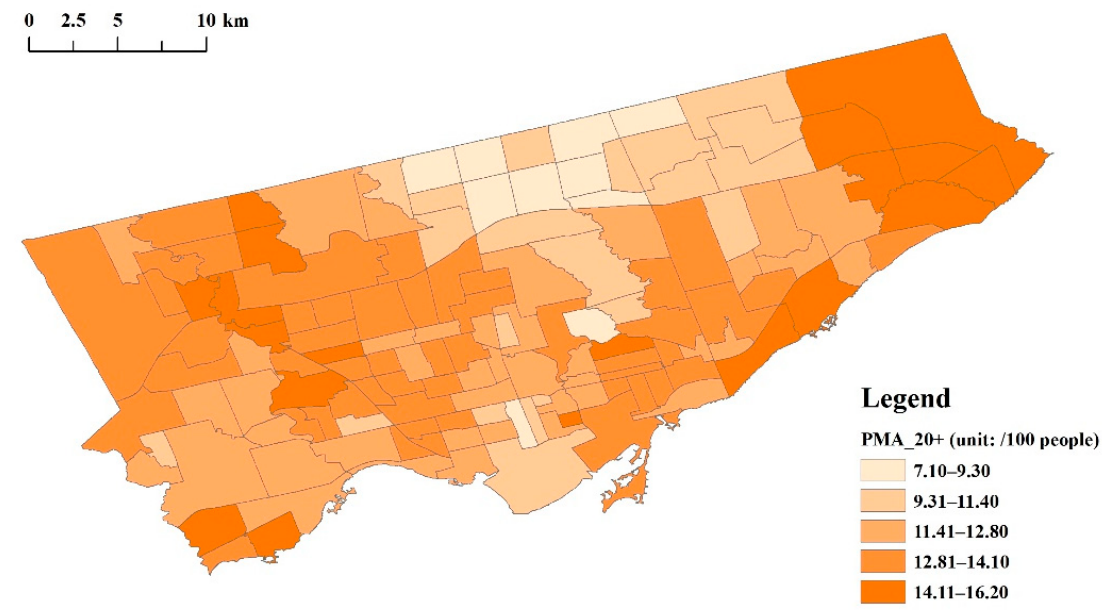
Figure A8. Distribution of the prevalence of male asthmatics aged 20 years and above (PMA_20+).